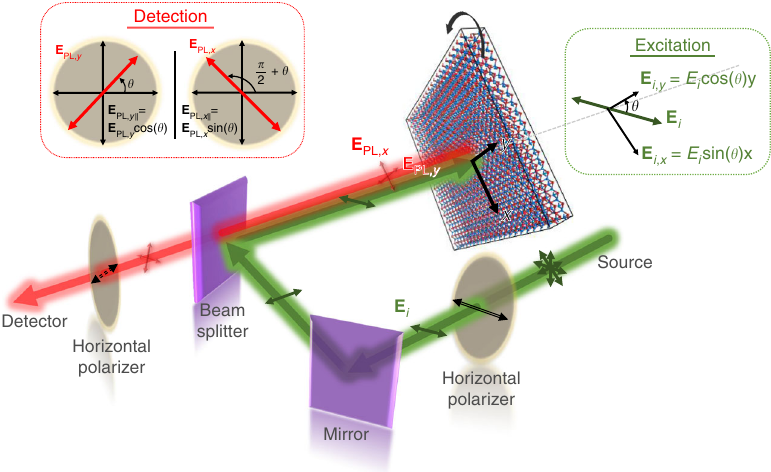
Fig. 2 Schematic of the experimental setup for both PL and re fl ection measurements. Excitation was conducted using linearly polarized light on a sample that can be rotated to give an angle θ between the polarization axis and the armchair direction. A second polarizer was also placed either parallel or perpendicular to the excitation polarization for PL measurements